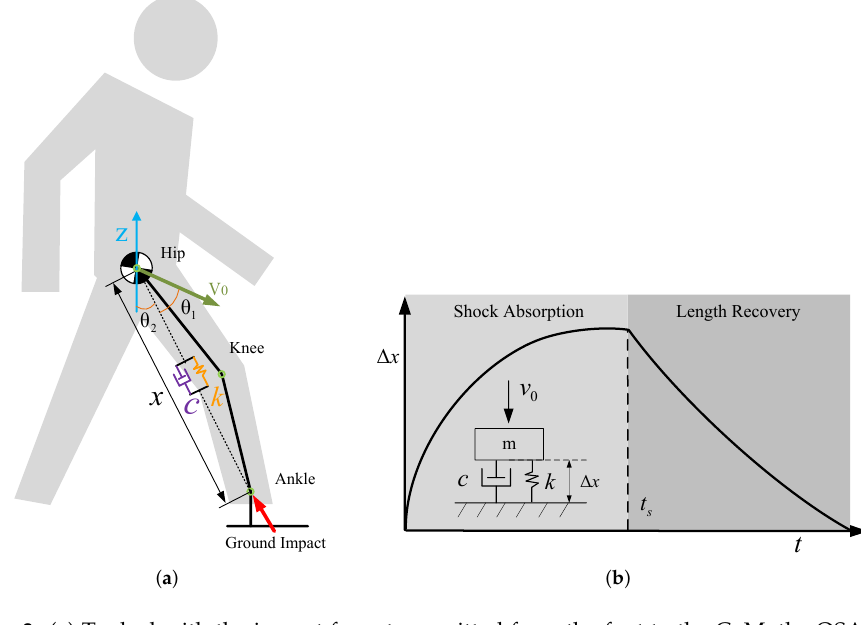
Figure 3. ( a ) To deal with the impact force transmitted from the foot to the CoM, the OSAM was introduced to guide hip–ankle distance variation, where x denotes the hip–ankle distance, k and c are stiffness and damping of the OSAM, respectively, and V 0 is the velocity of the CoM. ( b ) The typical variation in the hip–ankle distance for shock absorption and length recovery, where ∆ x denotes the OSAM response, v 0 is the contact velocity along the leg direction, and t s is the duration of shock